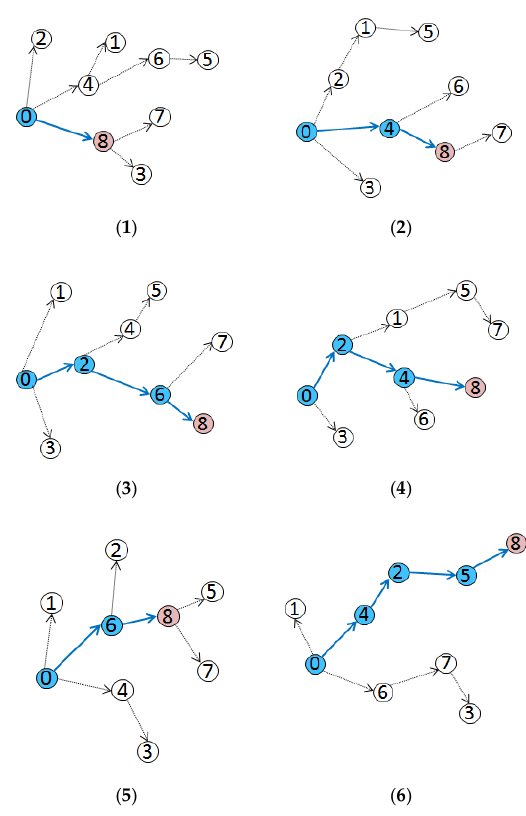
Figure 11. ( 1–6 ) Synchronization in six different topologies.